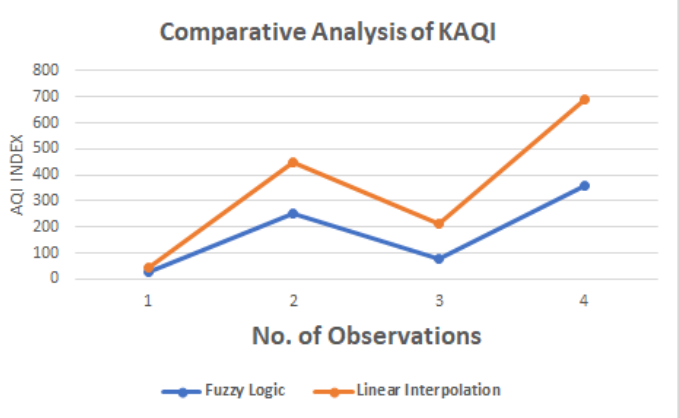
Figure 11. Comparative analysis of